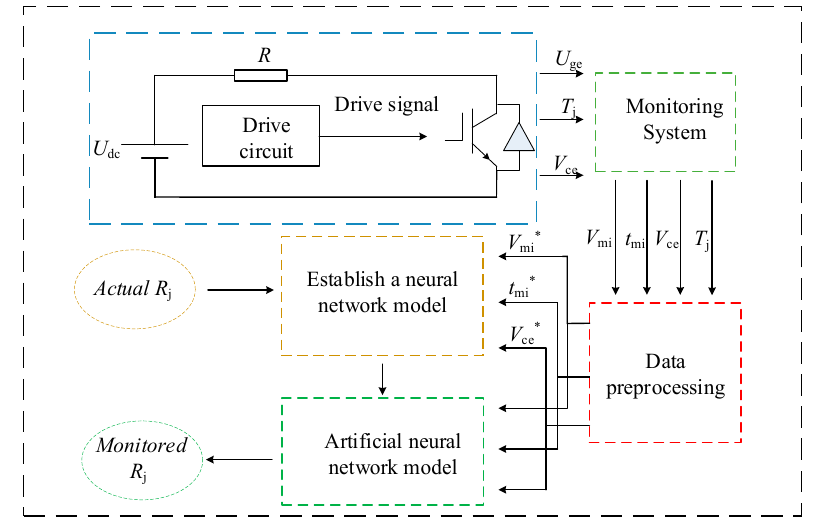
Figure 7. Process diagram of monitoring and analysis.